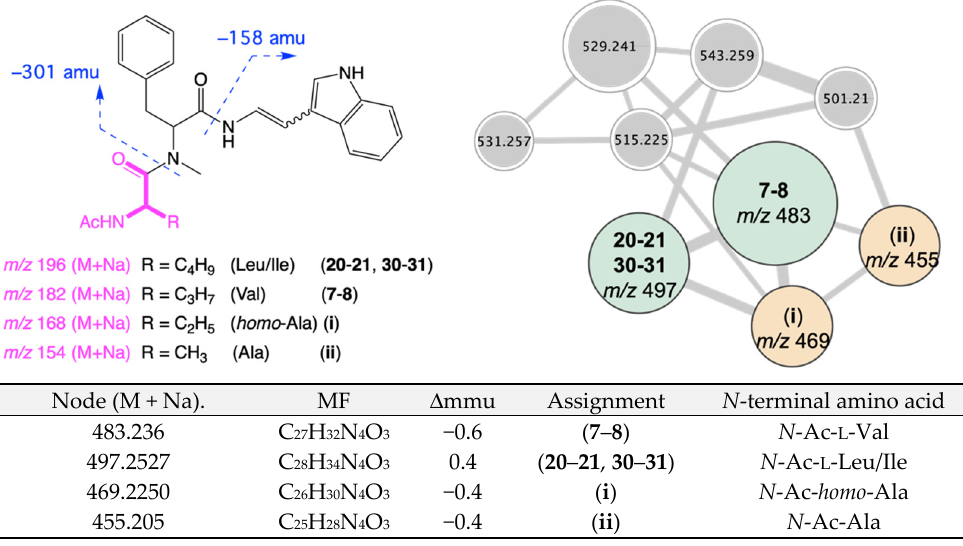
Figure 6. MS/MS fragmentation for nodes in the aspergillamide GNPS molecular family, revealing